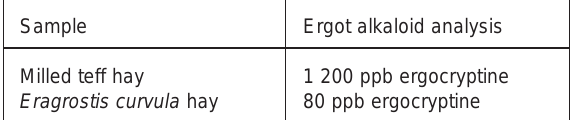
TABLE 5 Ergopeptine levels of feed in the third outbreak